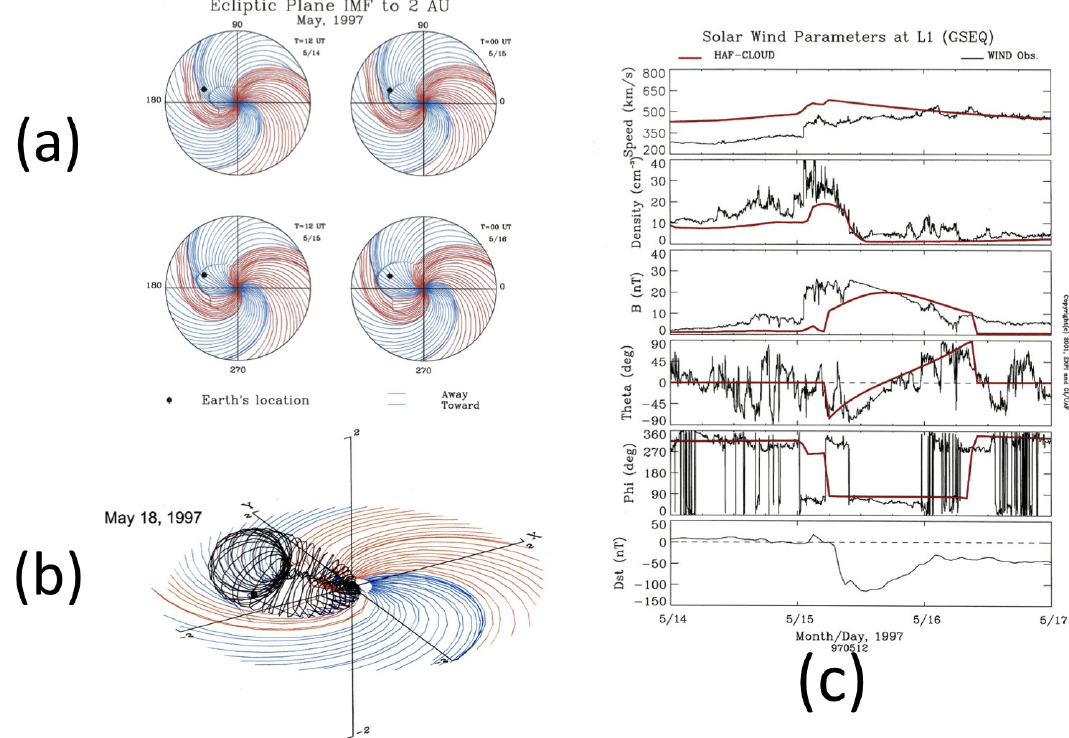
Figure 4. (a) The propagation of the shock wave associated with the 14–15 May 1997 geomagnetic storm (Fry et al., 2001); the location of the earth is indicated by a dot. (b) The reconstructed of the helical magnetic structure (Saito et al., 2007). (c) Comparison of results between the observation and the reconstructed helical structure (Saito et al., 2007; Akasofu,